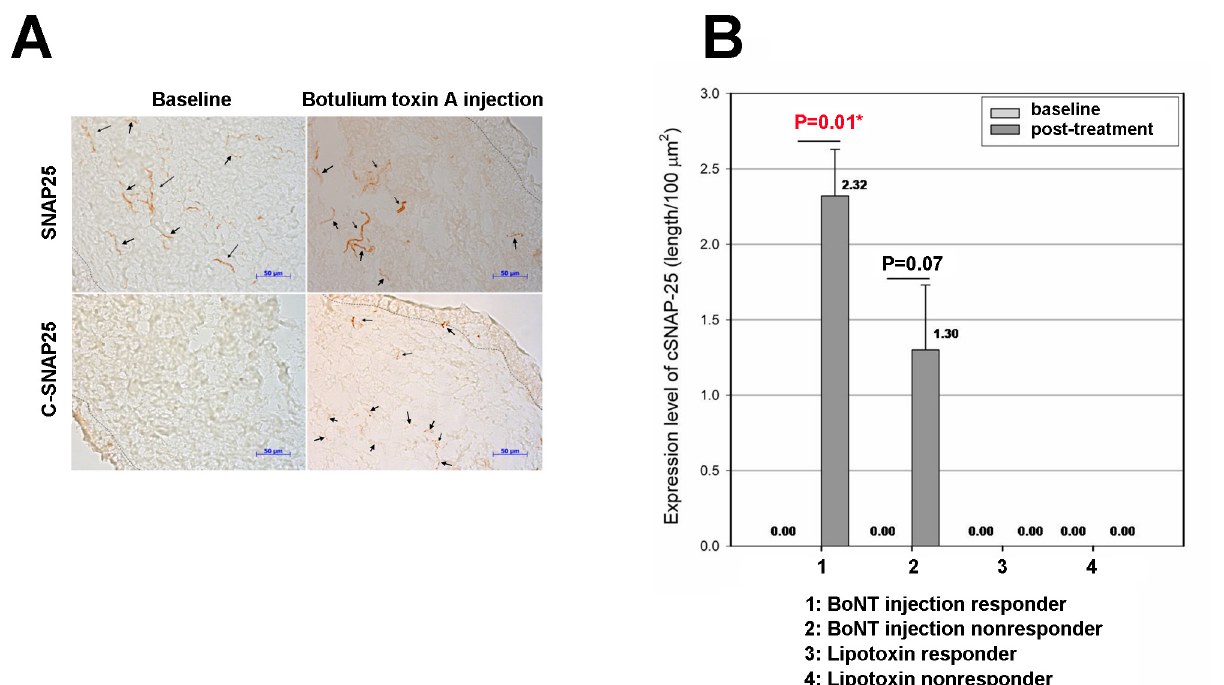
Fig 2. Immunohistochemistry staining of SNAP-25 and cleaved SNAP-25 (cSNAP-25) in bladder mucosa samples of OAB patients following BoNT-A injection. (A) SNAP-25 expression (arrows) was detected in patients at baseline and after BoNT-A treatment. cSNAP-25 was not detected at baseline but was present in the suburothelium of OAB bladders after BoNT-A injection. (B) Expression of cleaved SNAP-25 in patients receiving BoNT-A injections or lipotoxin treatment. There was no significant difference in cSNAP-25 expression between the BoNT-A responders and nonresponders. cSNAP- 25 was not detected in the OAB patients who underwent Lipotoxin treatment, whether at baseline or after treatment.